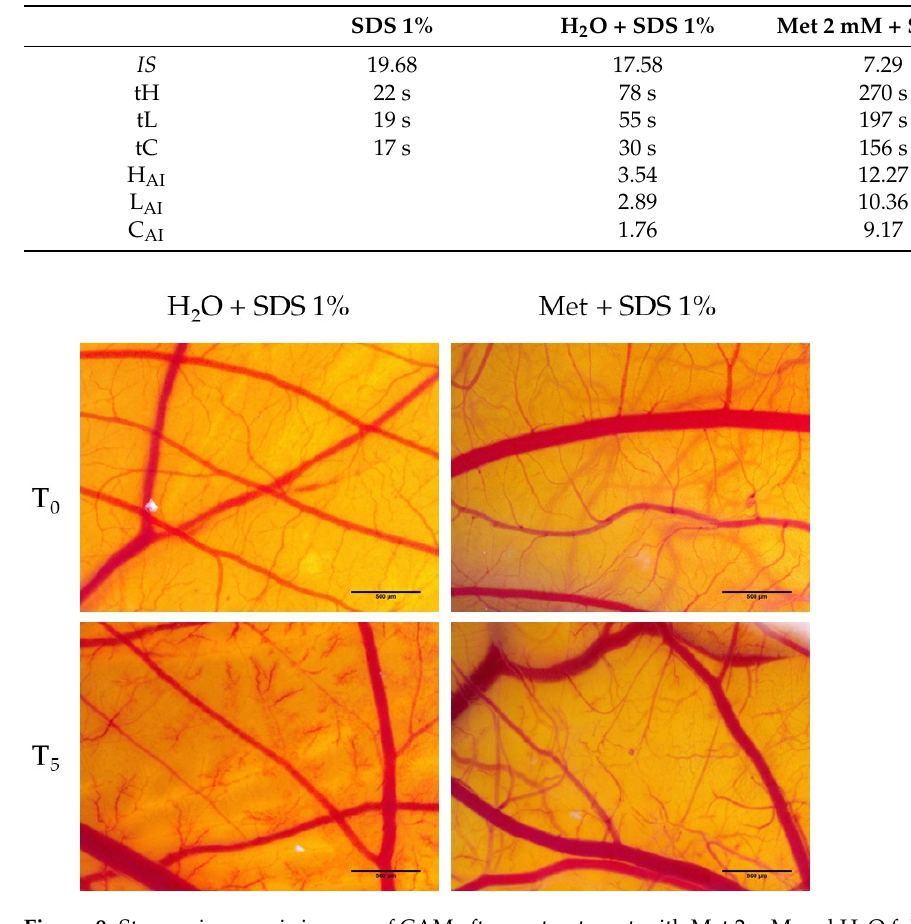
Figure 9. Stereomicroscopic images of CAM after pretreatment with Met 2 mM and H 2 O followed by 1% SDS irritation.